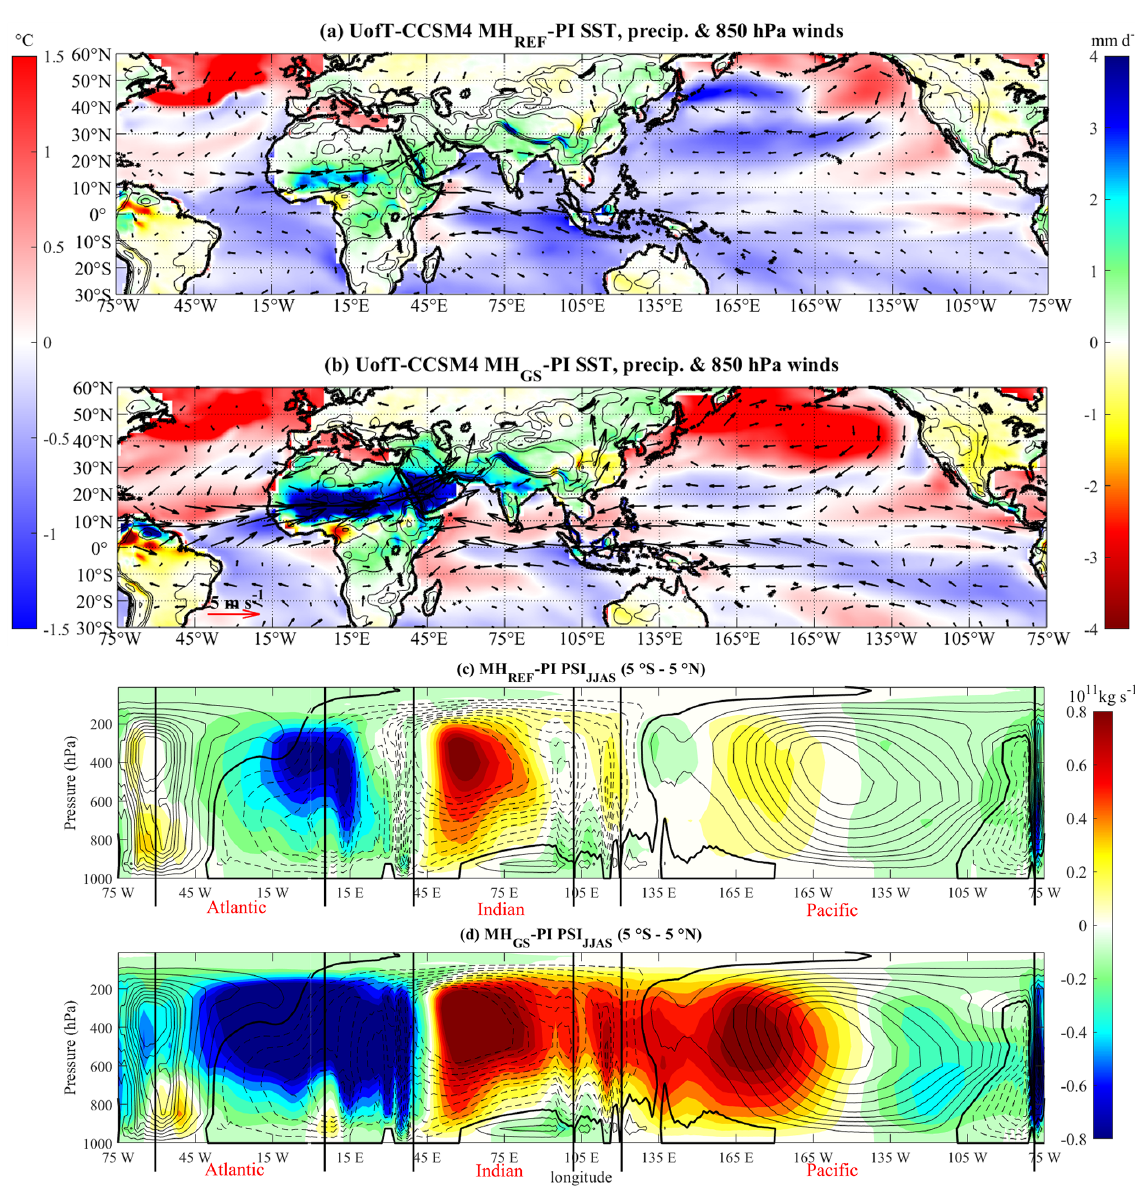
Figure 7. SST (shaded, ◦ C), precipitation (shaded, mmd − 1 ) and 850hPa winds (vector, ms − 1 ) anomalies during JJAS from UofT-CCSM4 for (a) MH REF and (b) MH GS . The topography contours of 500, 1000, 2000, and 4000m are also shown. PI climatological zonal stream function of the Walker circulation (contours: 0 . 2 × 10 11 kgs − 1 interval from − 2 to 2 × 10 11 kgs − 1 ; 0 line in bold) and associated changes (shaded) in (c) MH REF and (d) MH GS relative to the